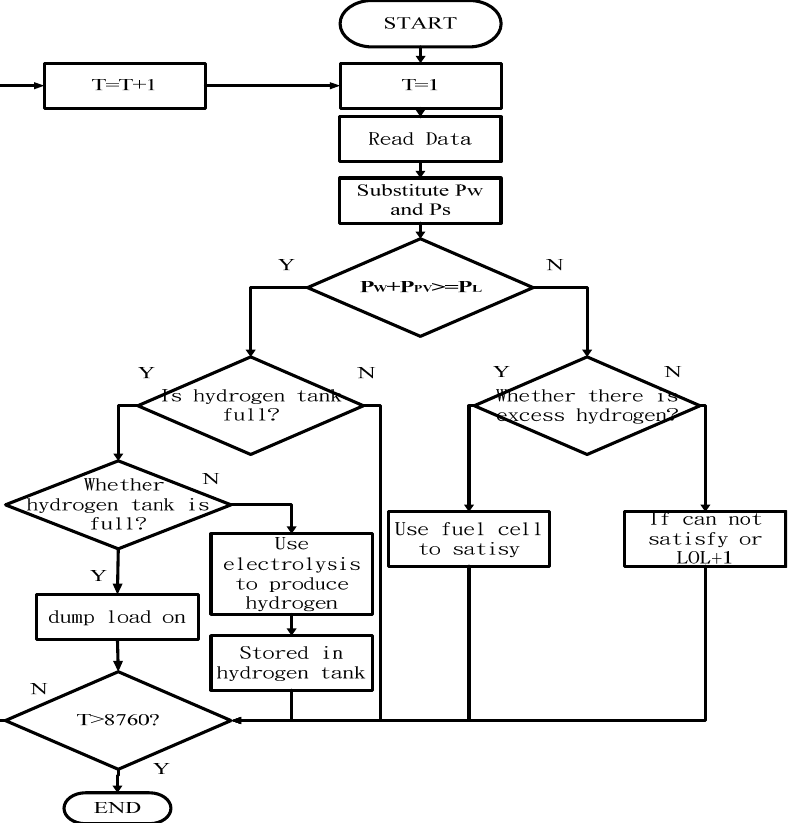
Figure 2. Operation flowchart of the proposed stand ‐ alone power system.